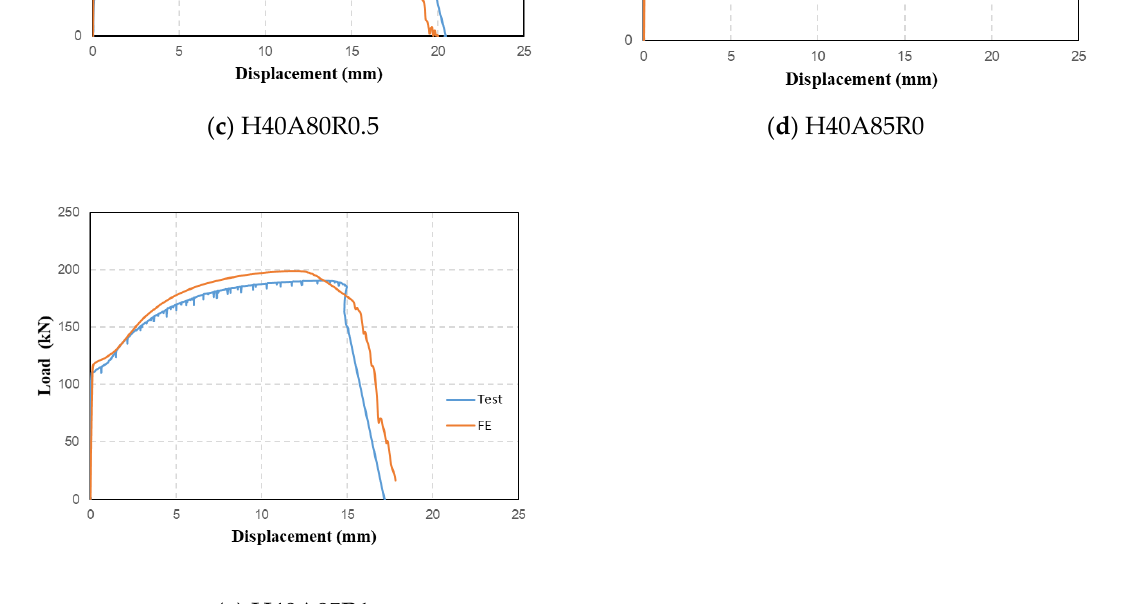
Figure 7. Comparisons of load–displacement curves between experimental and numerical results